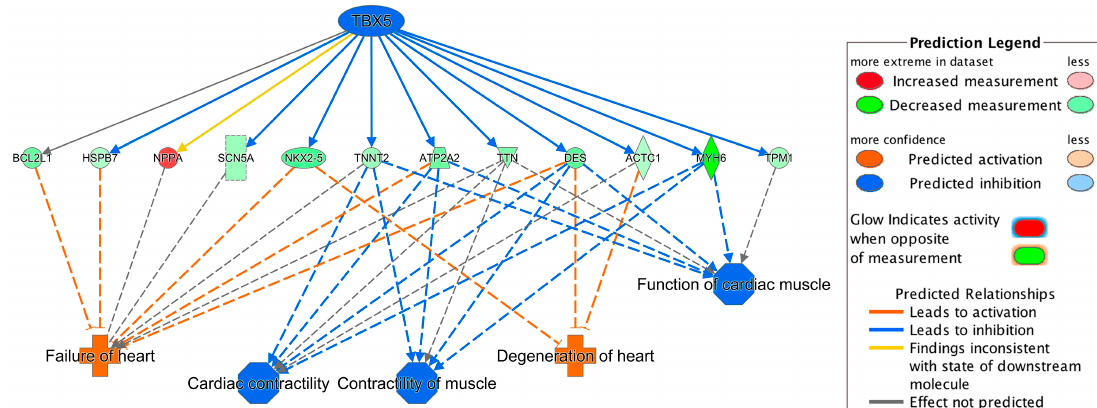
Figure 5. Network of TBX5 , its targeted genes and corresponding cardiac disorders. For example, inhibition of TBX5 leads to downregulation (indicated by blue line) of DES (shown by green color). Downregulation of DES further activates failure of heart (indicated by orange color). For other indicators, please refer to the Prediction Legend.